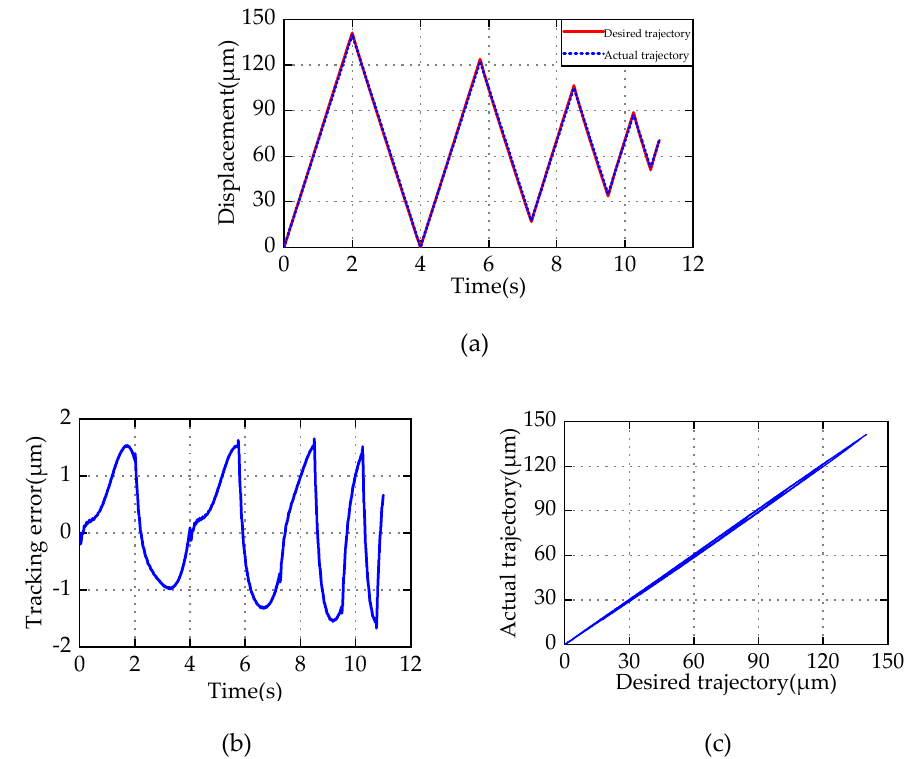
Figure 15. Frequency conversion attenuated triangular wave reference tracking experiment. ( a ) Trajectory tracking; ( b ) tracking error; ( c ) relationship between desired and actual displacement.